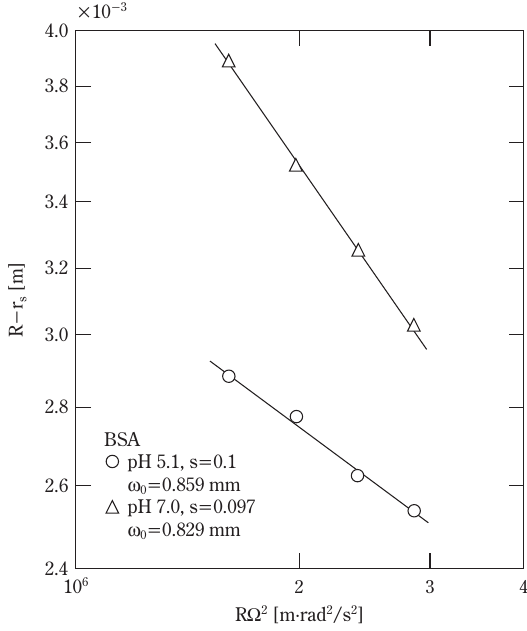
Fig. 9 Relation between equilibrium thickness of sediment and centrifugal